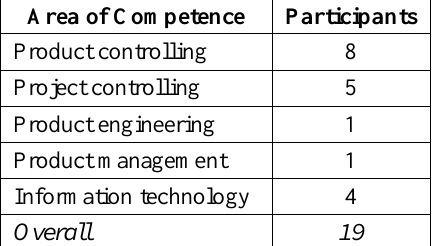
Table 1. Overview of study participants in relation to their areas of competence (study